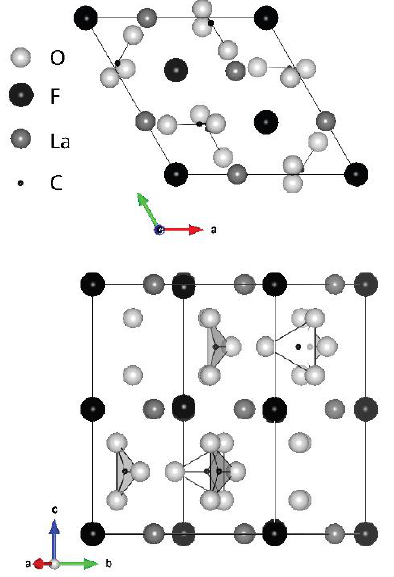
Figure 1. Structure of bastnäsite-(La) generated in the software VESTA [26], ( a ) as viewed down the c - axis, ( b ) as viewed down the a* - axis [4]. In both images, the trigonal planar polyhedral for the CO 32− ions are highlighted.